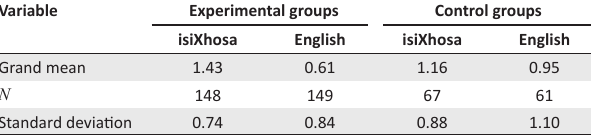
TABLE 6: Analysis of variance results on the ability to make predictions in English. Variable Sum of squares df Mean square F P Between treatments TABLE 7: A comparison on making predictions between English and isiXhosa. Variable Experimental groups